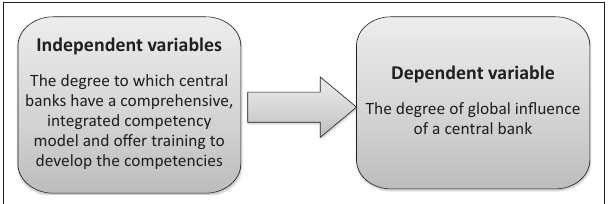
FIGURE 4: Relationship between the study